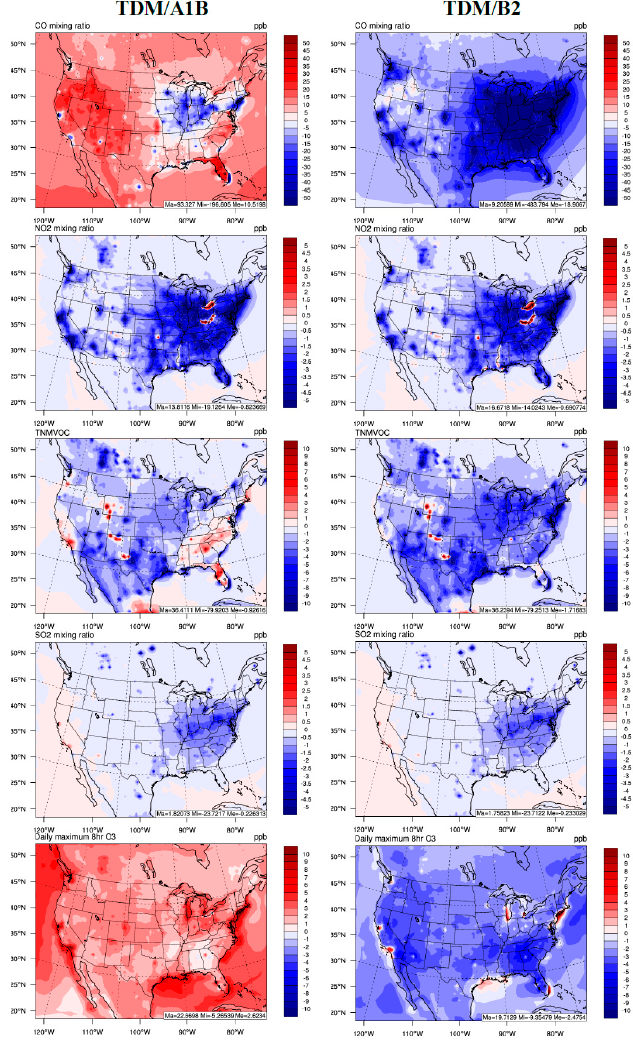
Figure 3. Absolute changes of annual average carbon monoxide (CO), nitrogen dioxide (NO 2 ), total non-methane volatile organic compounds (TNMVOCs), sulfur dioxide (SO 2 ), and daily maximum 8 hr ozone (O 3 ) between the future and current decade for TDM/A1B and TDM/B2.